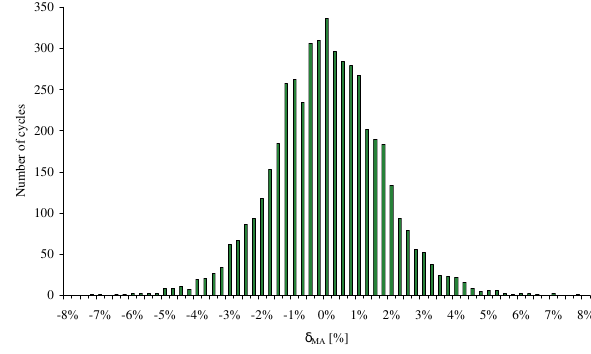
Fig. 12. Layout of the number of cycles for which error of survey falls within the ambit of particular